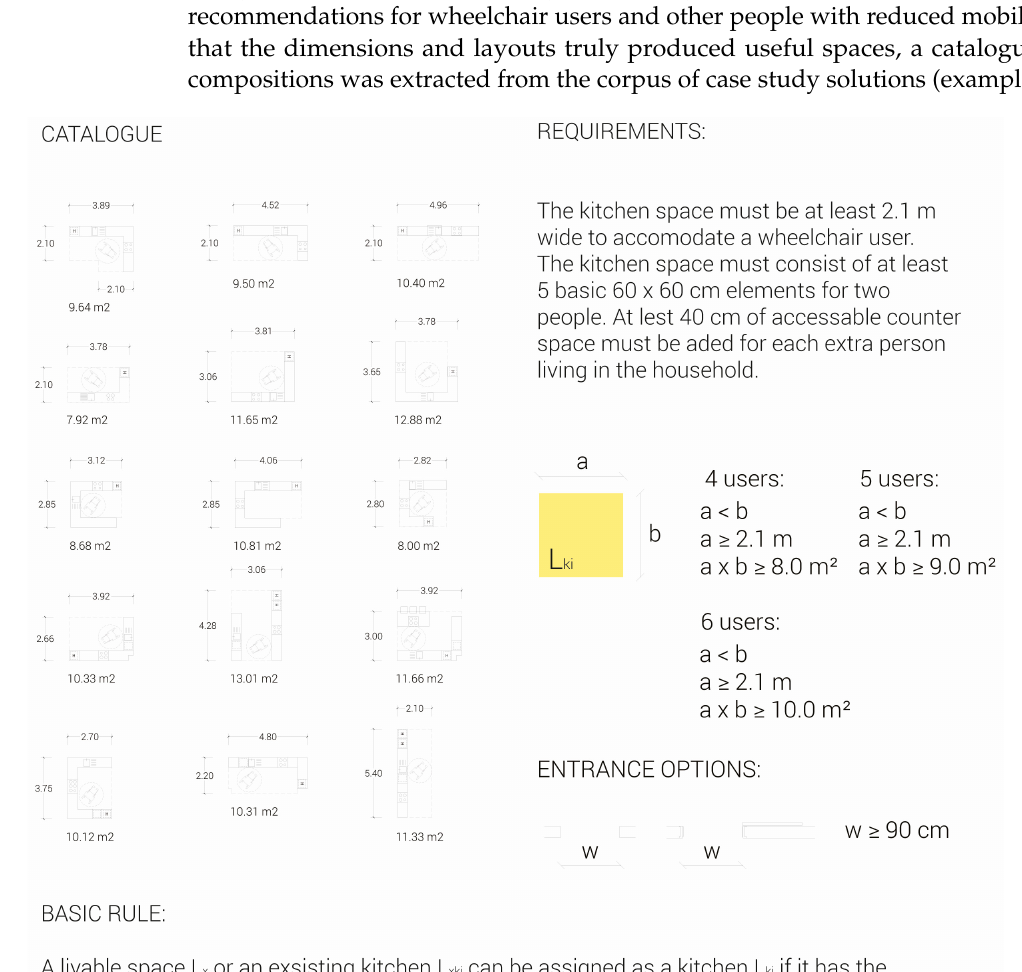
Figure 18. Kitchen requirements (Ana Bel č i č , 2022).